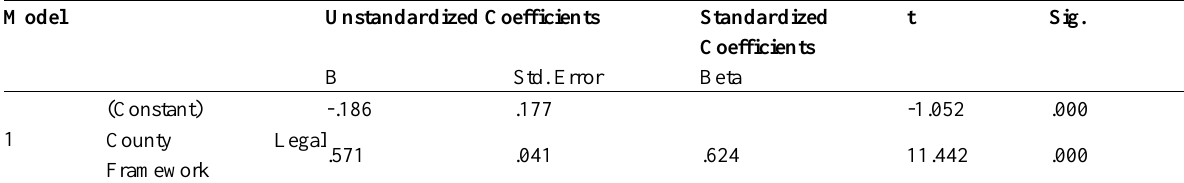
Table 7: Regression